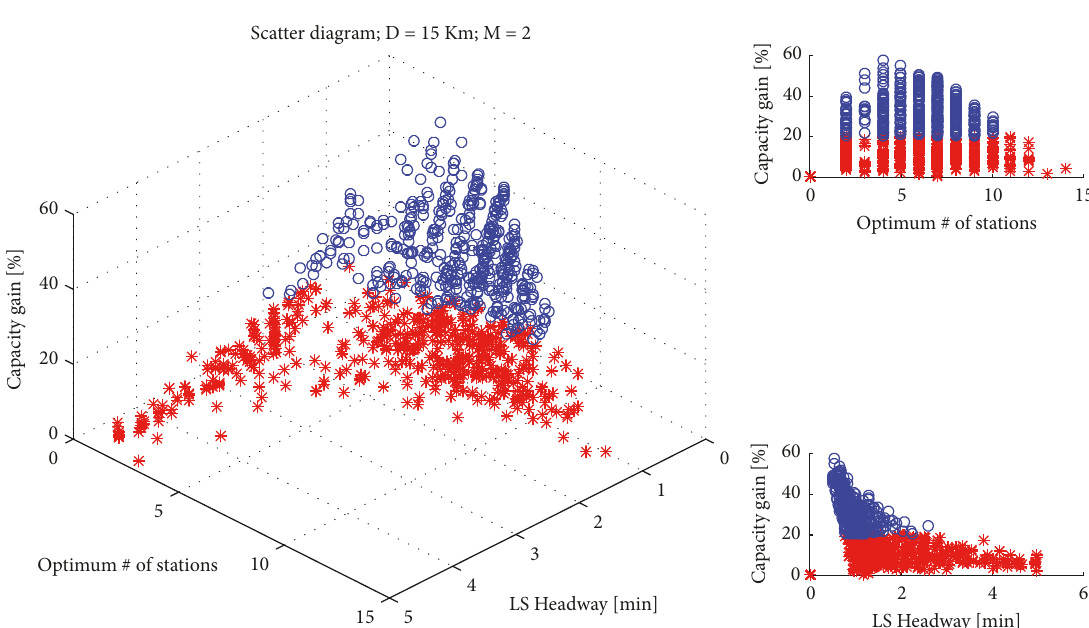
Figure 6: Scatter diagram of the capacity gain against the optimum number of LS stations and the LS headway. Blue dots correspond to capacities above the mean, while red points are below